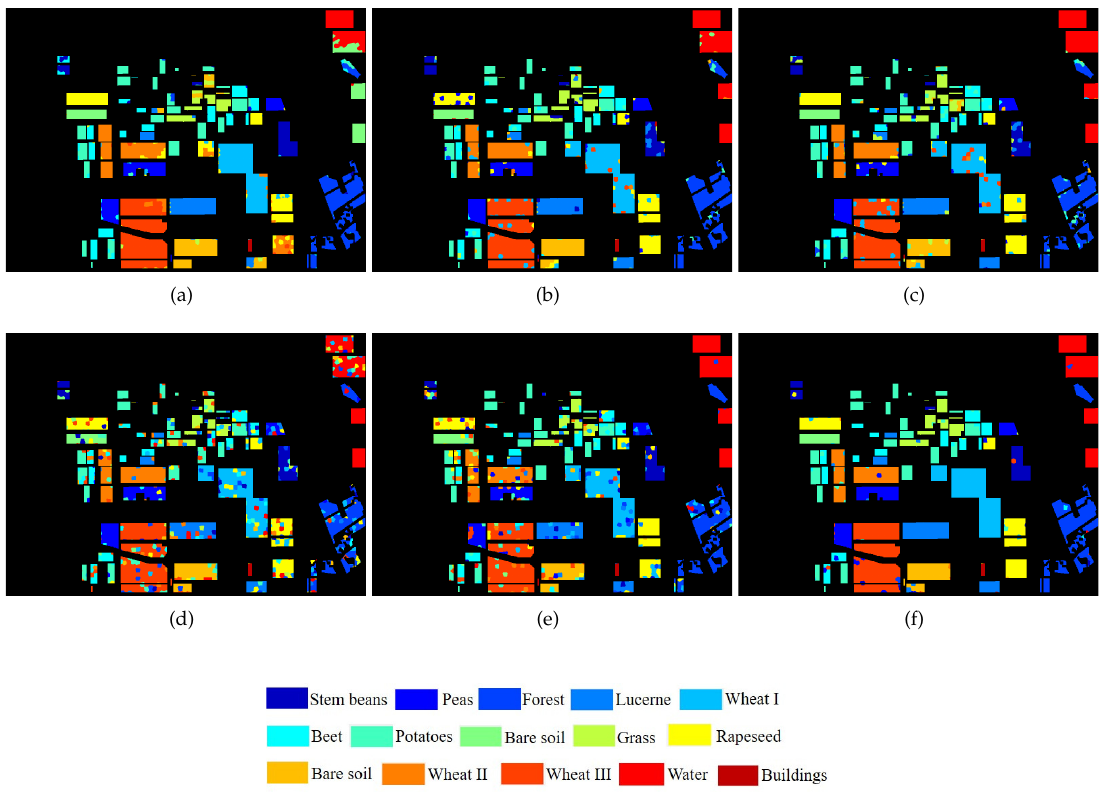
Figure 9. Visual classification results on the Flevoland data set. ( a ) the Wishart classifier, ( b ) PCA, ( c ) LE ( d ) PFLE, ( e ) WDLE and ( f ) the proposed